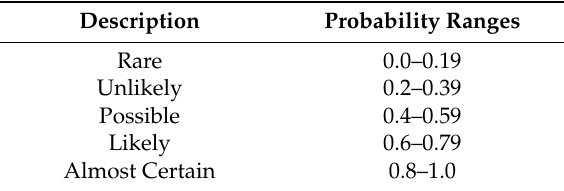
Table 2. Likelihood.